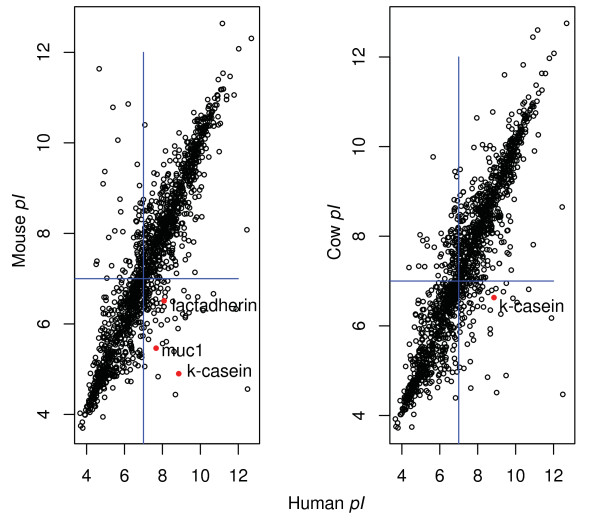
pI values of all the orthologous proteins in human, mouse, and cow. The vertical and horizontal lines represents the neutral pH = 7. Most proteins have a similar pI between species, with some exceptions lying out on both sides of the diagonal. The red dots represent the three milk proteins that have the highest shift (κ-casein, lactadherin, and muc1).